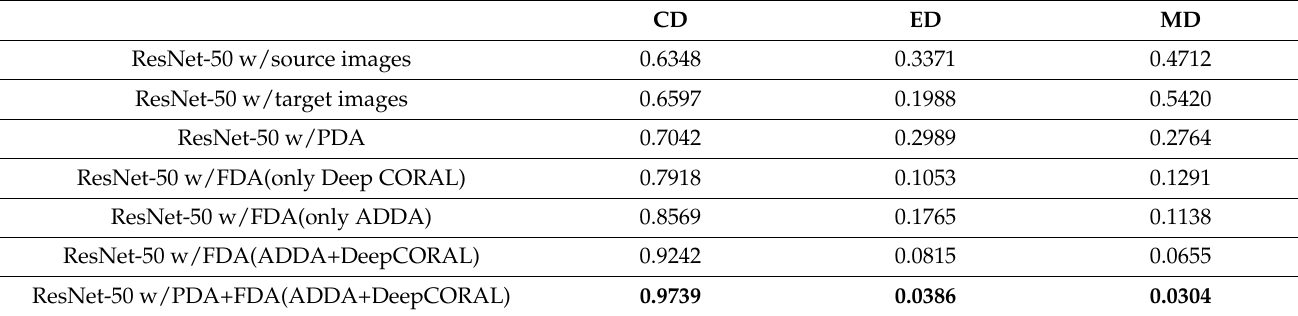
Bold indicates that the results shown in this line are the